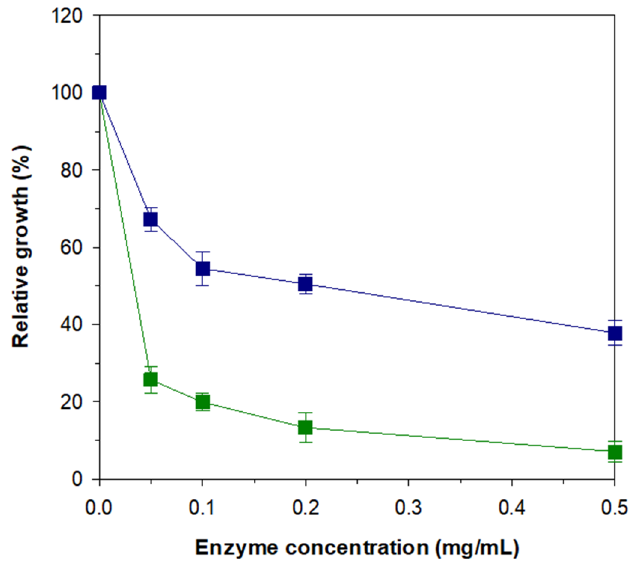
Figure 7. Inhibitory effects of rGluY ( ■ ) and rGluY Δ RICIN ( ■ ) on the growth of C. albicans . The values are mean ± SD of triplicate tests.